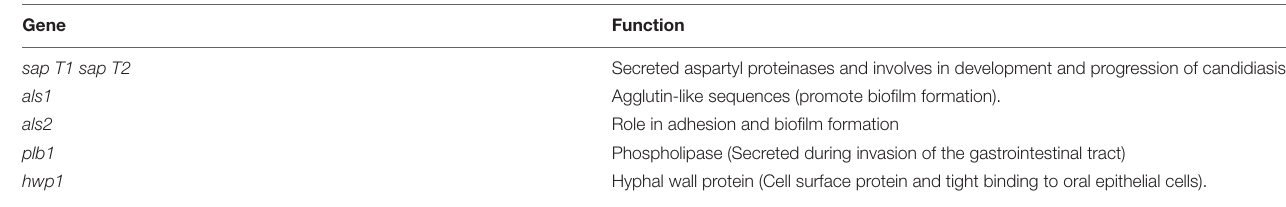
TABLE 1 | List of C. albicans virulence genes and their functions used in this study. Gene